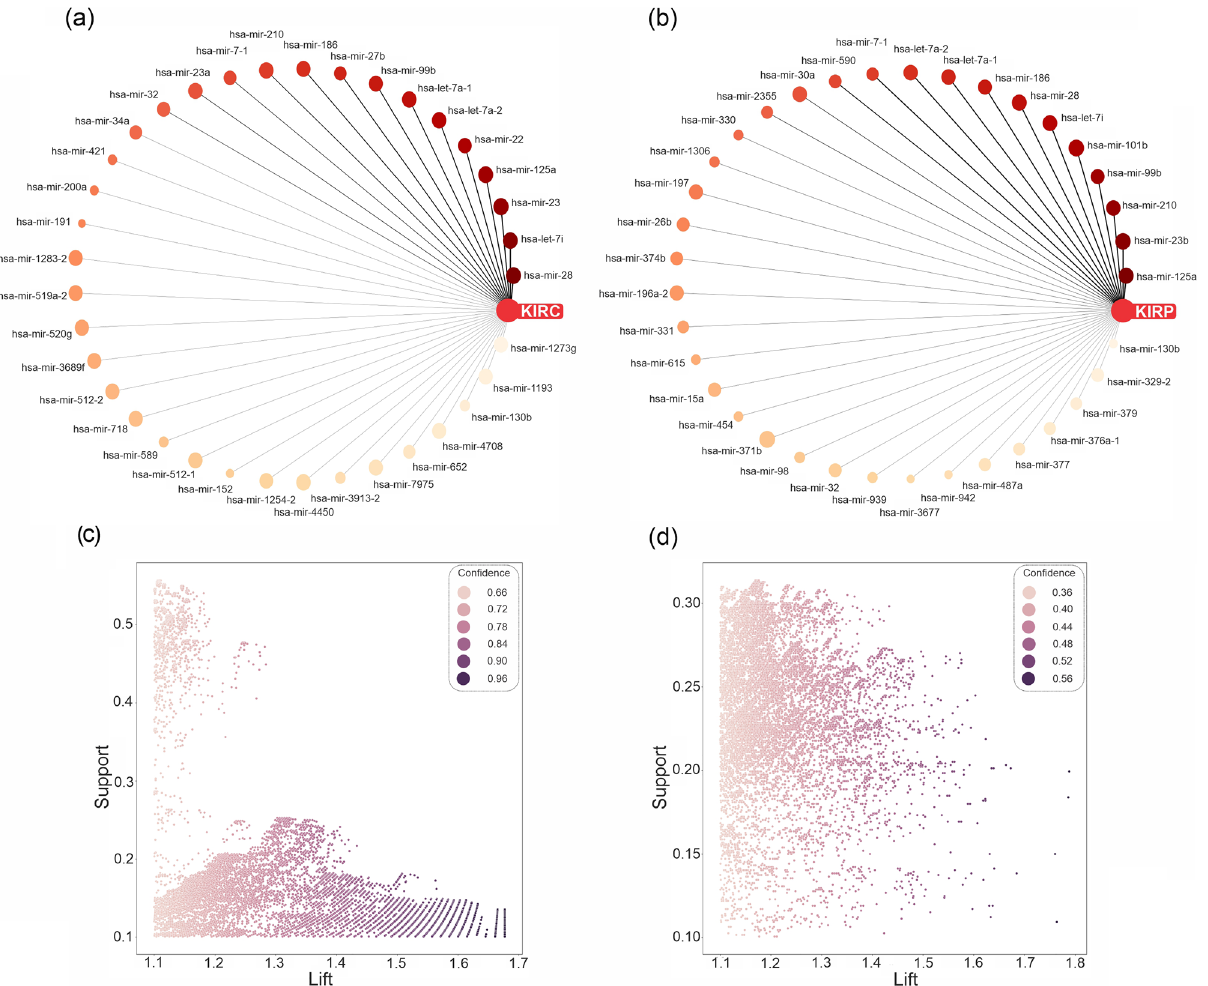
Figure 4. The relationship and specification of the KIRC/KIRP association rules in the miRNA data. Graph network of top miRNAs with high repeat count in ( a ) KIRC and ( b ) KIRP association rules. The most frequent miRNAs were displayed with the weight of the edge based on repeat counts. Also, the AMGM value of miRNAs was illustrated with the size of the node. Strength distribution of ( c ) KIRC and ( d ) KIRP association rules according to their support, lift, and confidence. KIRC kidney renal clear cell carcinoma, KIRP kidney renal papillary cell carcinoma, KICH kidney chromophobe